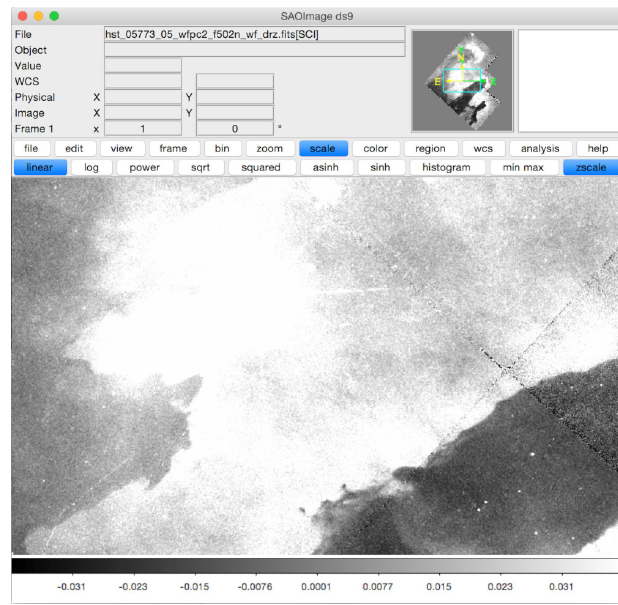
Fig. 36.— HST Eagle nebula image in DS9 with zscale applied fairly raw, and rather different from the pretty astron- omy pictures you see in the media. But at least we can discern some structures. The main window below the two rows of menus only shows part of the image. In the overview window (second to right, on top) you can see the whole of the image. The cyan frame in the overview window marks the part of the image that is visible in the main window. Drag it around (left-click the mouse and drag) to explore other parts of the image. Alternatively, you can go to “zoom” in the main menu and choose one of the options in the secondary menu to see the image as a whole (“zoom fit”), or in more detail (e.g. “zoom 2”).